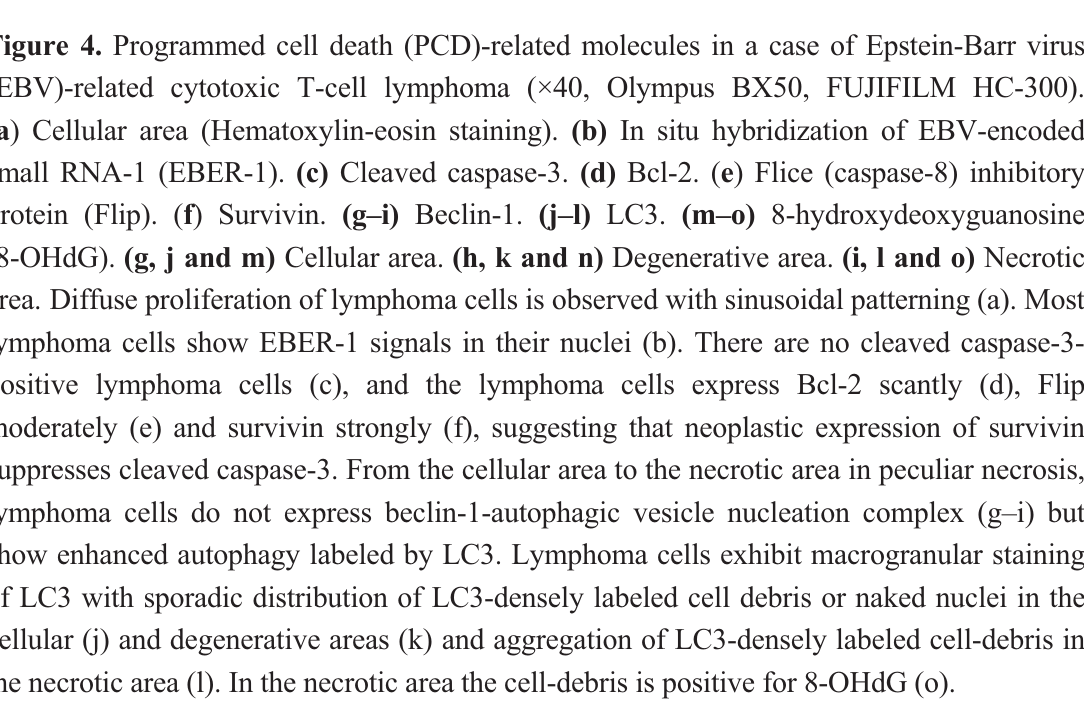
Figure 4. Programmed cell death (PCD)-related molecules in a case of Epstein-Barr